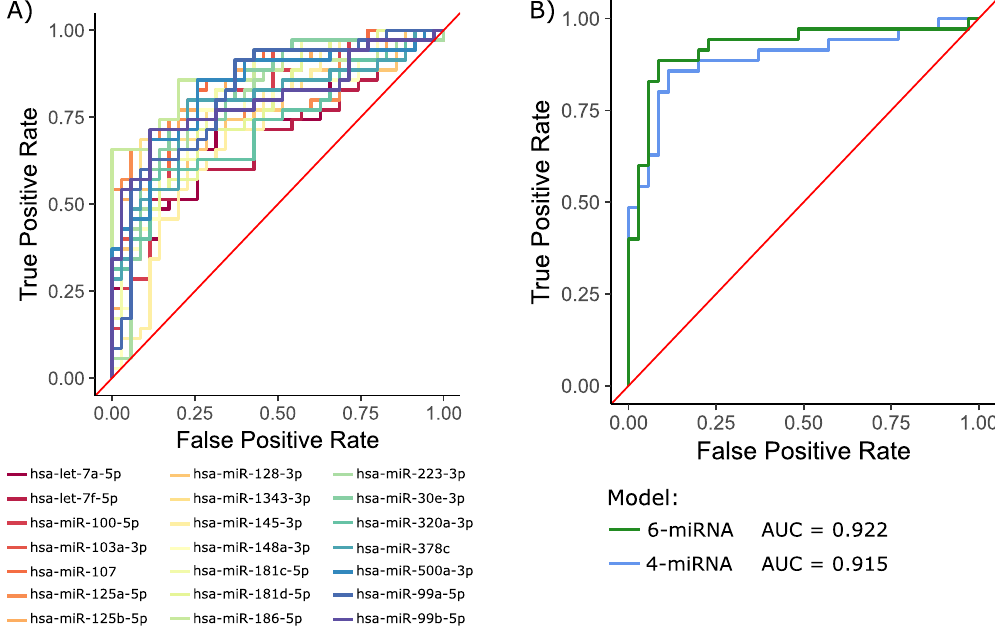
Figure 4. Diagnostic potential of serum miRNA biomarkers. The ability for the relative abundance of each miRNA biomarker in serum to differentiate CWD positive from negative elk (by IHC) was visualized using ROC analysis. ( A ) ROC curves were constructed for each of the 21 putative serum miRNAs of CWD in elk. Logistic regression was used to model CWD status (classified as 1 = CWD positive, 0 = CWD negative; CWD status was assigned by IHC) with abundance of serum miRNA biomarkers. Lasso penalized logistic regression models were built using the log2 transformed read counts of 6 (hsa-miR-185-5p, hsa-miR-500a-3p, hsa-miR- 99a-5p, hsa-miR-125b-5p, hsa-miR-181c-5p and hsa-miR-181d-5p) and 4 (hsa-miR-30e-3p, hsa-miR-500a-3p, hsa-miR-125b-5p, hsa-miR-181c-5p) miRNAs. ( B ) The diagnostic accuracy for each logistic regression model was assessed using ROC